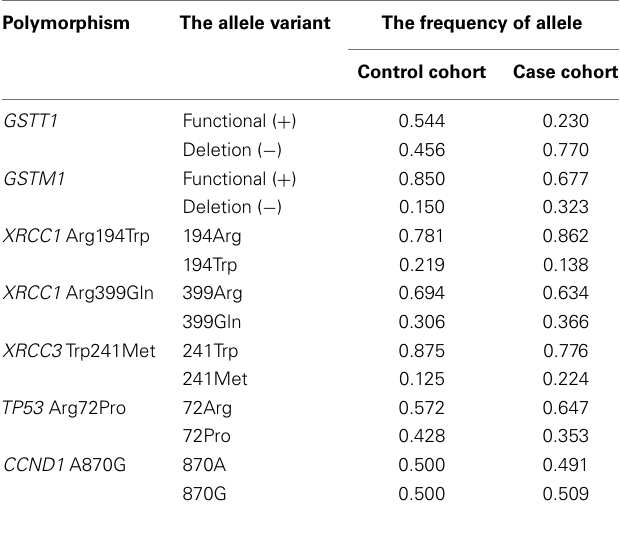
Table 6 |The frequencies of alleles of candidate genes in control and case cohorts for cervical cancer.